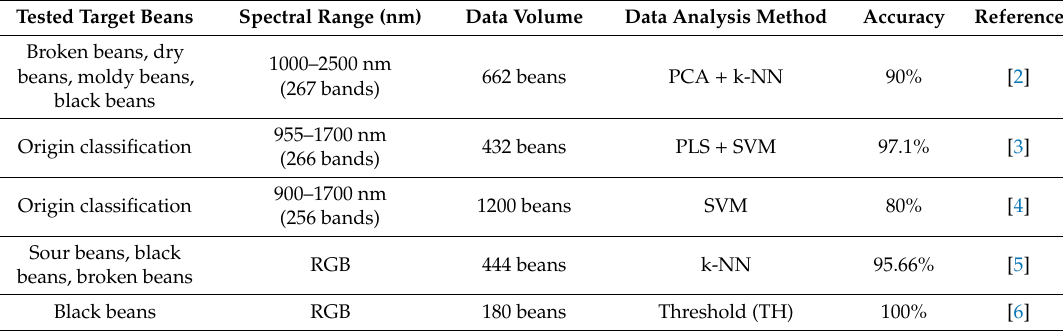
Table 1. Existing green co ff ee bean evaluation